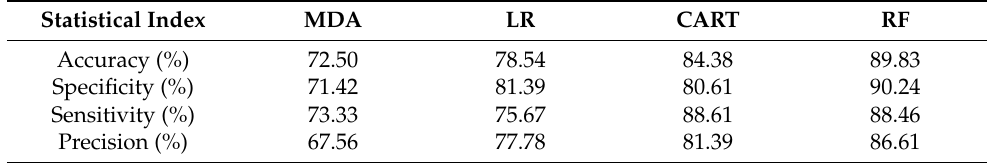
Table 4. Predictive capability of models using test data.